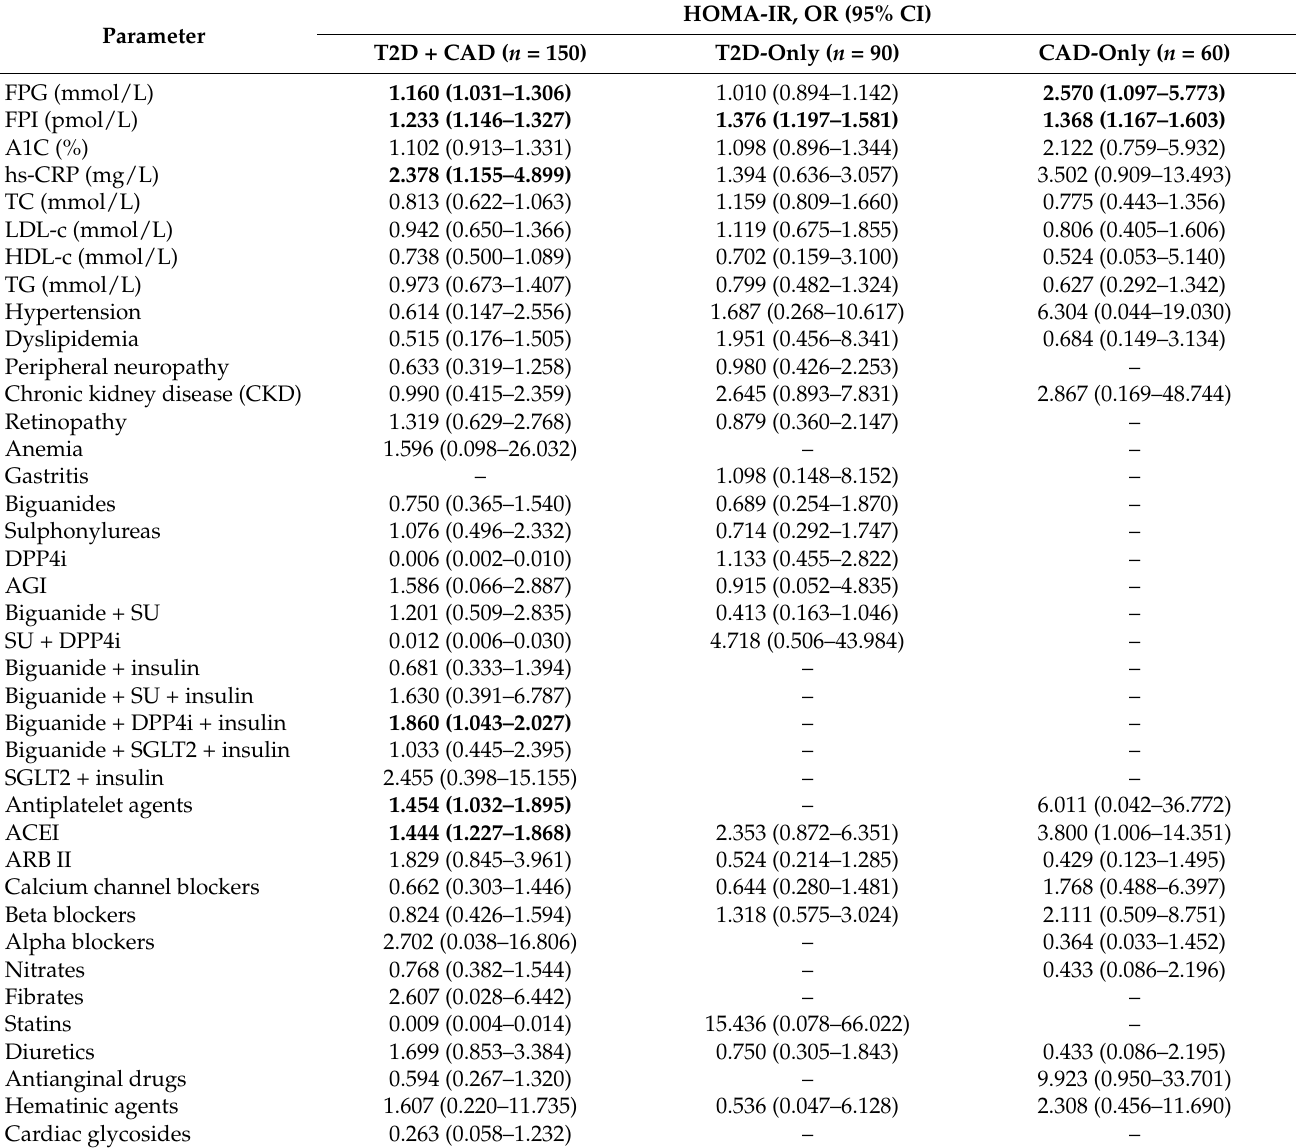
Table 2. Association of clinical factors with IR in study